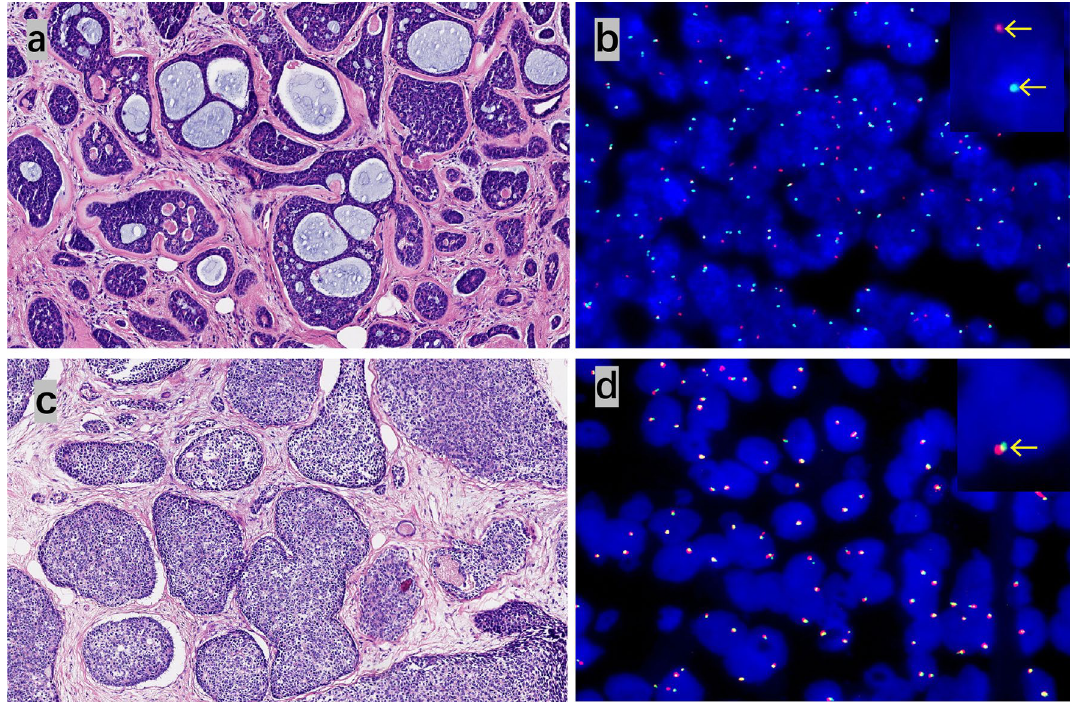
Figure 3. The MYB fluorescence in situ hybridization in classic and solid-basaloid AdCCs. Envoy H&E micrograph and corresponding FISH image using MYB break-apart assay demonstrating red and green signals for separation of C-AdCC in ( a ) and ( b ); ( c ) and ( d ) represent H&E and FISH micrographs in SB-AdCC with no rearrangement involving